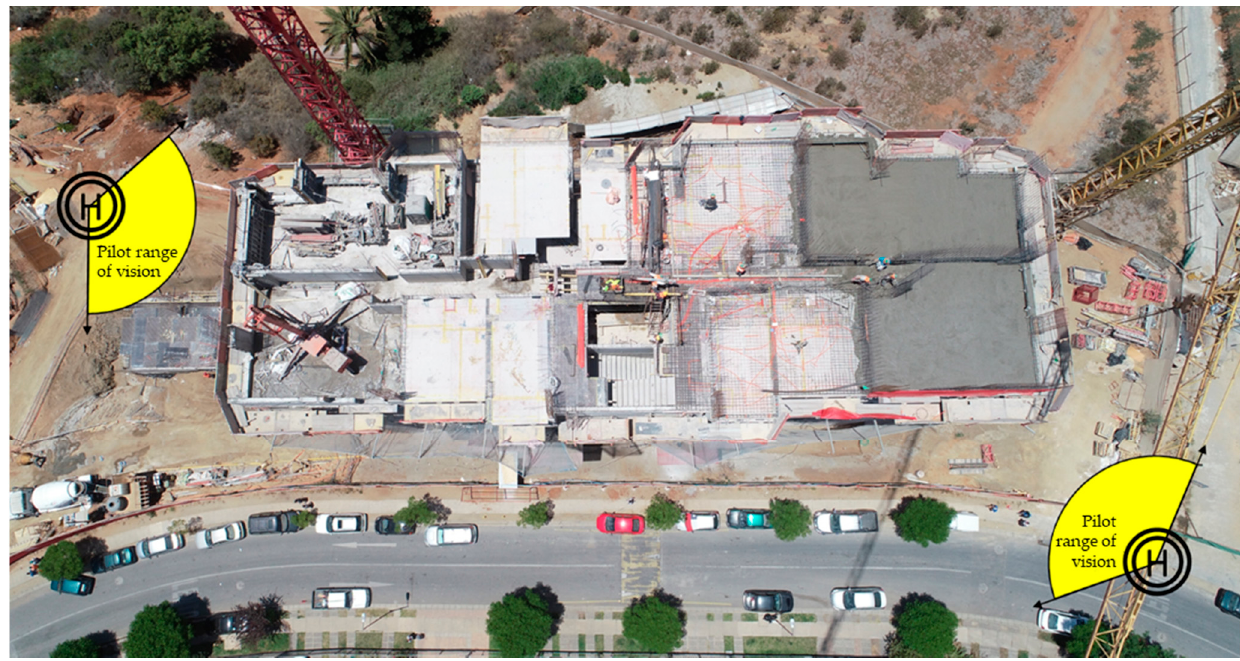
Figure 5. Selected locations for complete inspection of the structure.